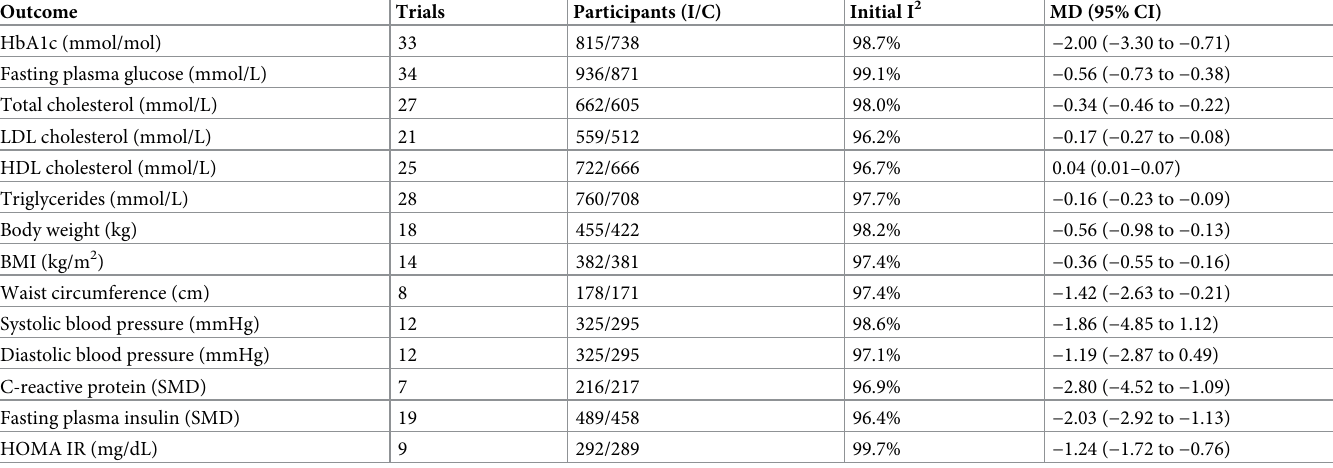
Table 1. Summary differences in glycaemic control and cardiometabolic risk factors between intervention and control groups from trials of increasing fibre